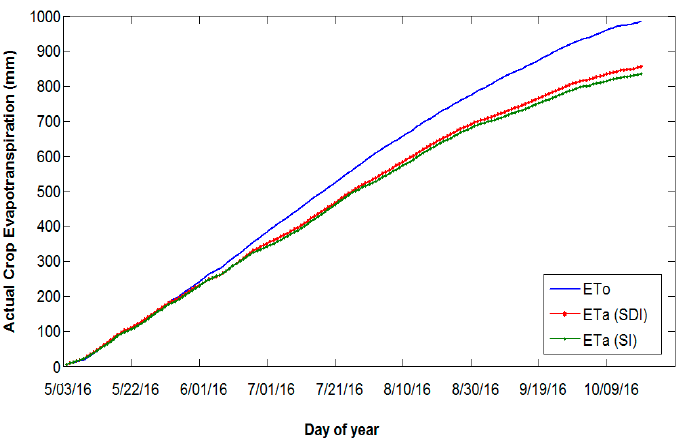
Figure 2. Cumulative actual alfalfa evapotranspiration (ETa) obtained with the residual of energy balance (REB) method through commercial surface renewal (SR) equipment for surface irrigation (SI) and sub-surface drip irrigation (SDI) during 2016 at the UC Davis experiment.